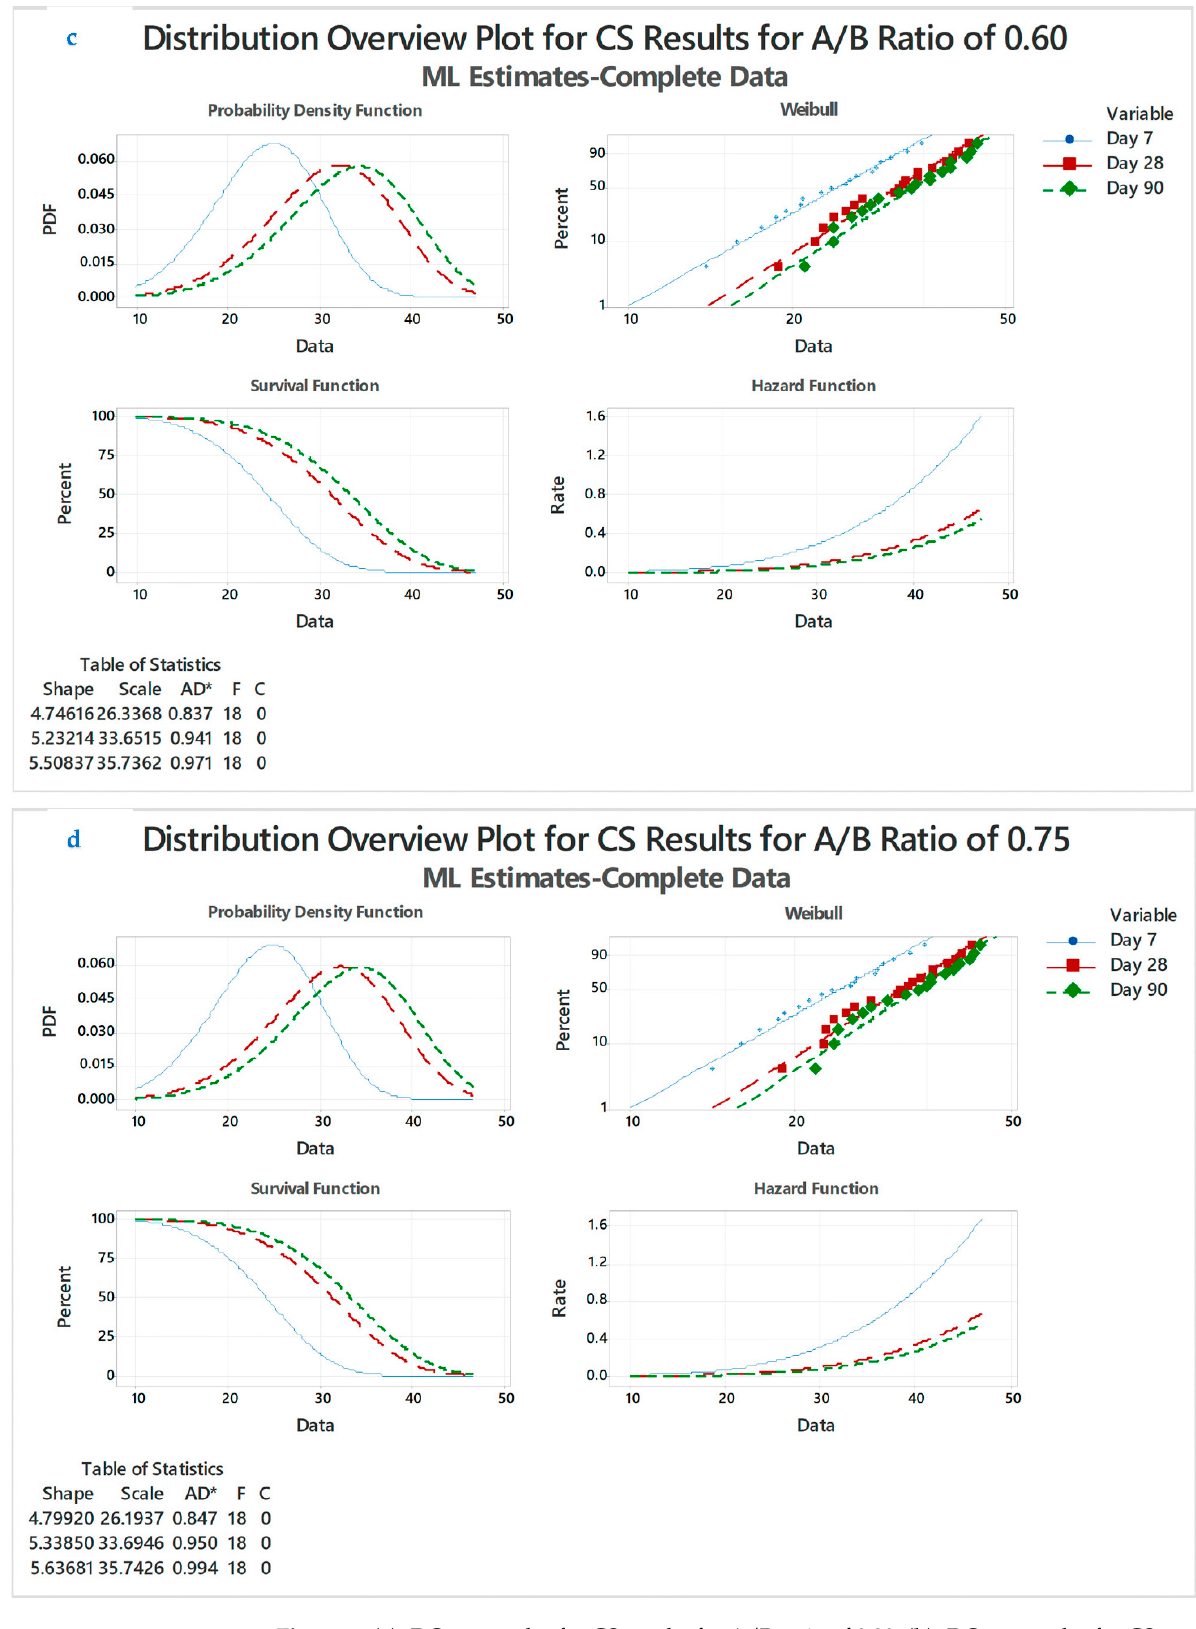
Figure 6. ( a ). DO curve plot for CS results for A/B ratio of 0.30; ( b ). DO curve plot for CS results for A/B ratio of 0.45; ( c ) DO curve plot for CS results for A/B ratio of 0.60, and ( d ) DO curve plot for CS results for A/B ratio of 0.75.